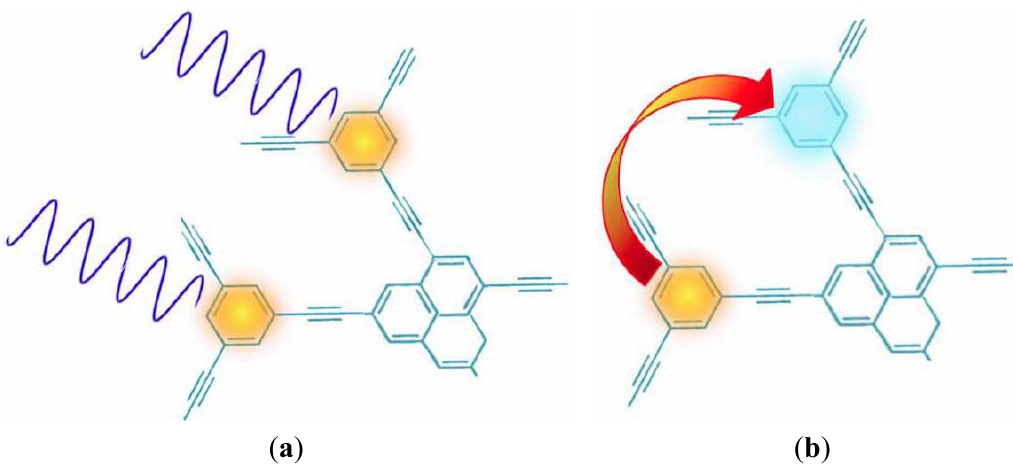
Figure 8. A mechanism for delivering the energy of two photons to a single site (specific dendrimer components shown only for illustration); ( a ) two peripheral antenna chromophores are excited; ( b ) the energy acquired by one of the chromophores is transferred to the other, which becomes doubly